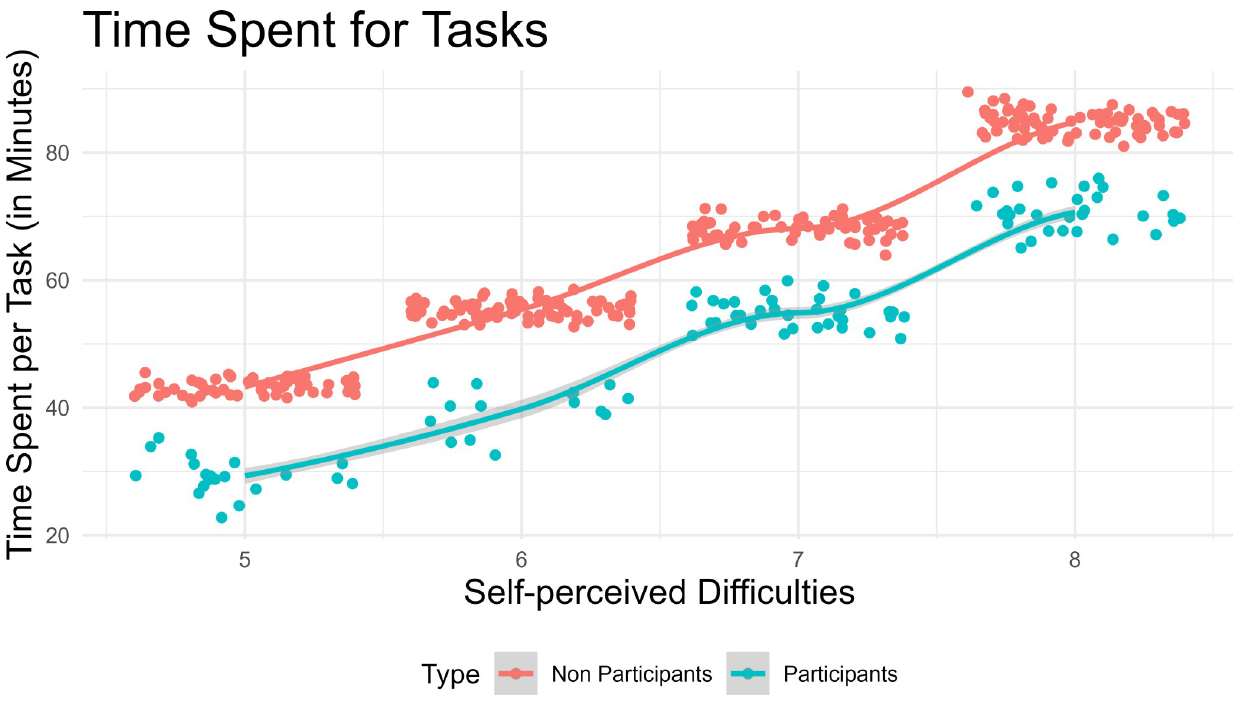
Fig 3. Time spent for tasks in informal